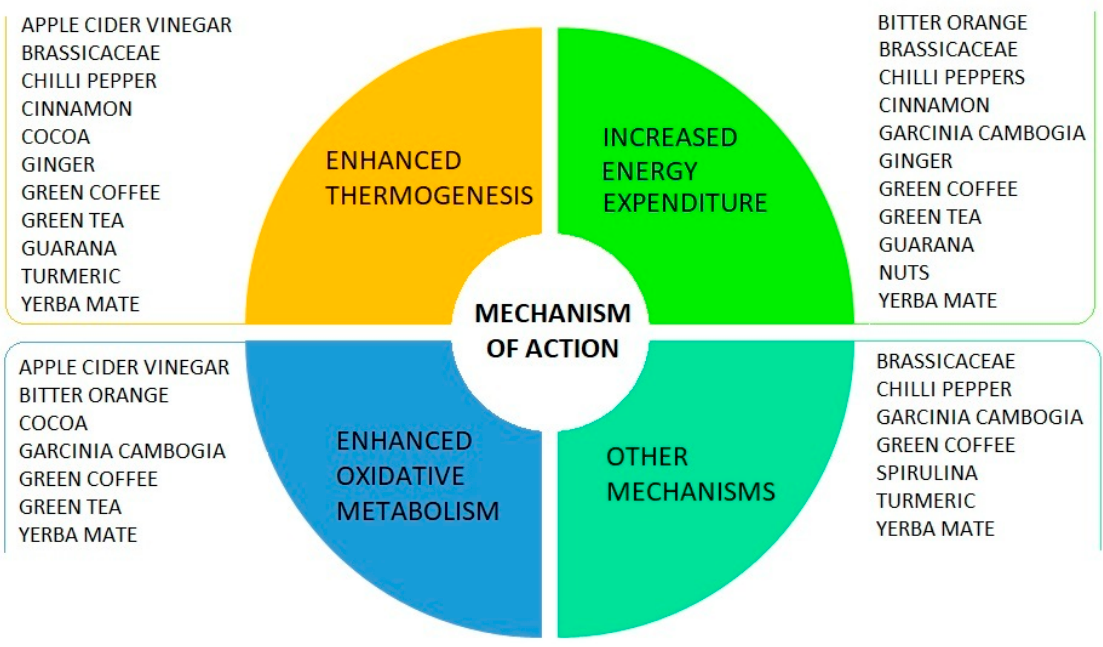
Figure 1. Supposed mechanisms of action of food impacting on energy balance .